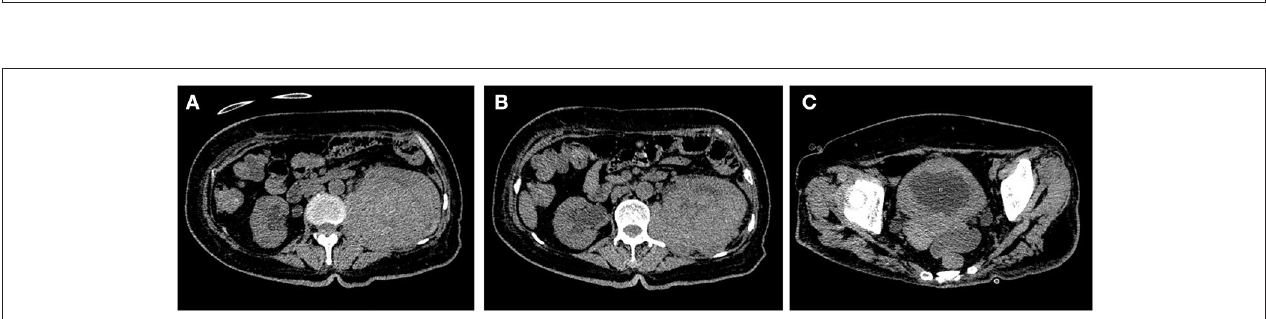
FIGURE 3 | The pathological examination of left kidney puncture showed proliferative fibrous tissue with a small amount of lymphocyte and plasma cell infiltration, PAS and hexamine silver staining (–). Histopathological examination of bladder mass showed that there were many eosinophilic granular tissue cells in the lamina propria of mucosa, scattered in small circular basophilic inclusions, consistent with bladder soft spot disease. Immunohistochemistry: CK (epithelium + ), CD68 ( + ), CD8/18 (epithelium + ), GATA (epithelium + ), S100 (scattered + ), Ki-67 (5%); Special staining: pas ( + ).